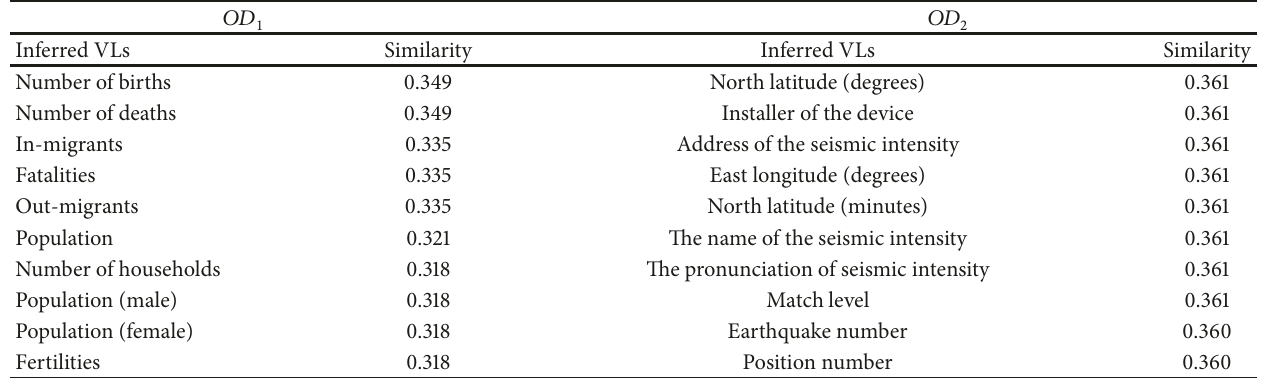
Table 2: The examples of top-ten VLs inferred by